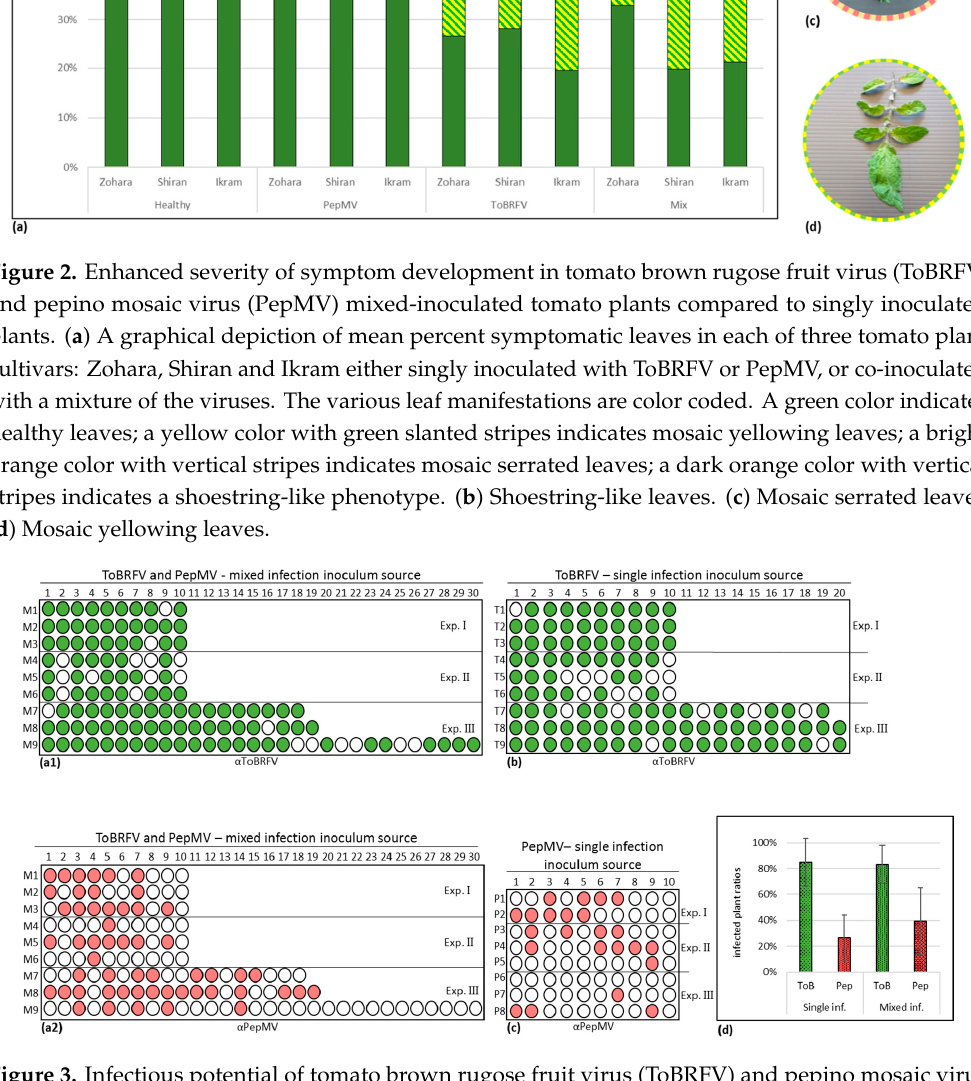
Figure 3. Infectious potential of tomato brown rugose fruit virus (ToBRFV) and pepino mosaic virus (PepMV) singly and mixed-infected tomato plants. ( a )–( d ) Depiction of enzyme-linked immunosorbent assay results. ( a1 ) A spread range of ToBRFV from ToBRFV and PepMV mixed-infection inoculum source ( n = 127). ( a2 ) A spread range of PepMV from ToBRFV and PepMV mixed-infection inoculum source ( n = 127). ( b ) A spread range of ToBRFV from ToBRFV single infection inoculum source ( n = 119). ( c ) A spread range of PepMV from PepMV single infection inoculum source ( n = 80). ( d ) A graphical depiction of calculated mean percentages of infected plants. Bars represent the standard deviation of the mean. Exp., experiment; ToBRFV detection results are green colored; PepMV detection results are pin colored; ToB, ToBRFV; Pep, PepMV; inf, infection; n , number of total plants.